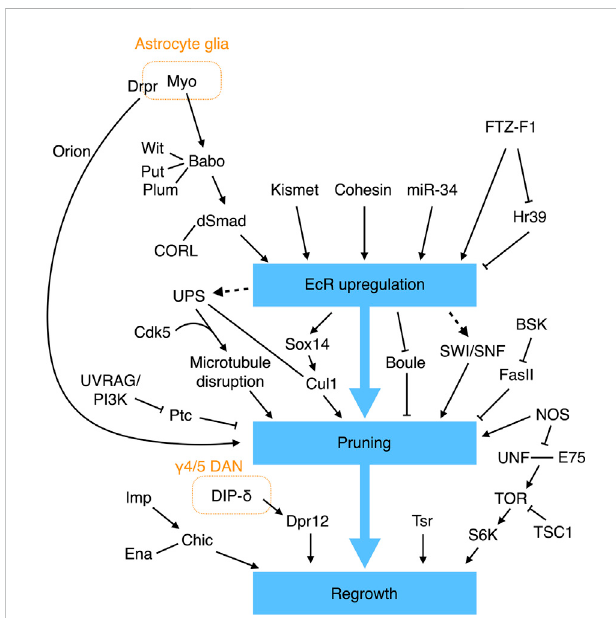
FIGURE 4 Molecular pathways regulating γ KC axonal pruning. EcR signaling plays a central role in regulating γ KC axonal pruning. EcR expression is regulatedbymultiplemoleculesandsignalingpathways.AdditionalEcR- independentpathwayshavealsobeenfoundtocontrol γ KCaxonal pruning and